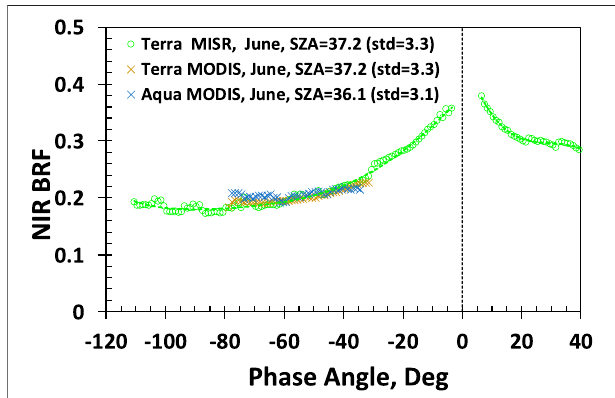
FIGURE 6 | Near-infrared BRF of Amazonian forests con fi ned between 0 ° to 10 ° S and 60 ° W to 70 ° W from Terra MISR, Terra MODIS, and Aqua MODISsensorsfortheperiodbetweenJune25andJuly10accumulatedover a 7-years period from 2001 to 2008. The MISR sensor views the Earth ’ s surface with nine cameras simultaneously, as opposed to the two MODIS sensors, which are capable of only one view each. The MISR observing geometryallowsformeasurementsofangularsignaturesoverawiderrangeof phase